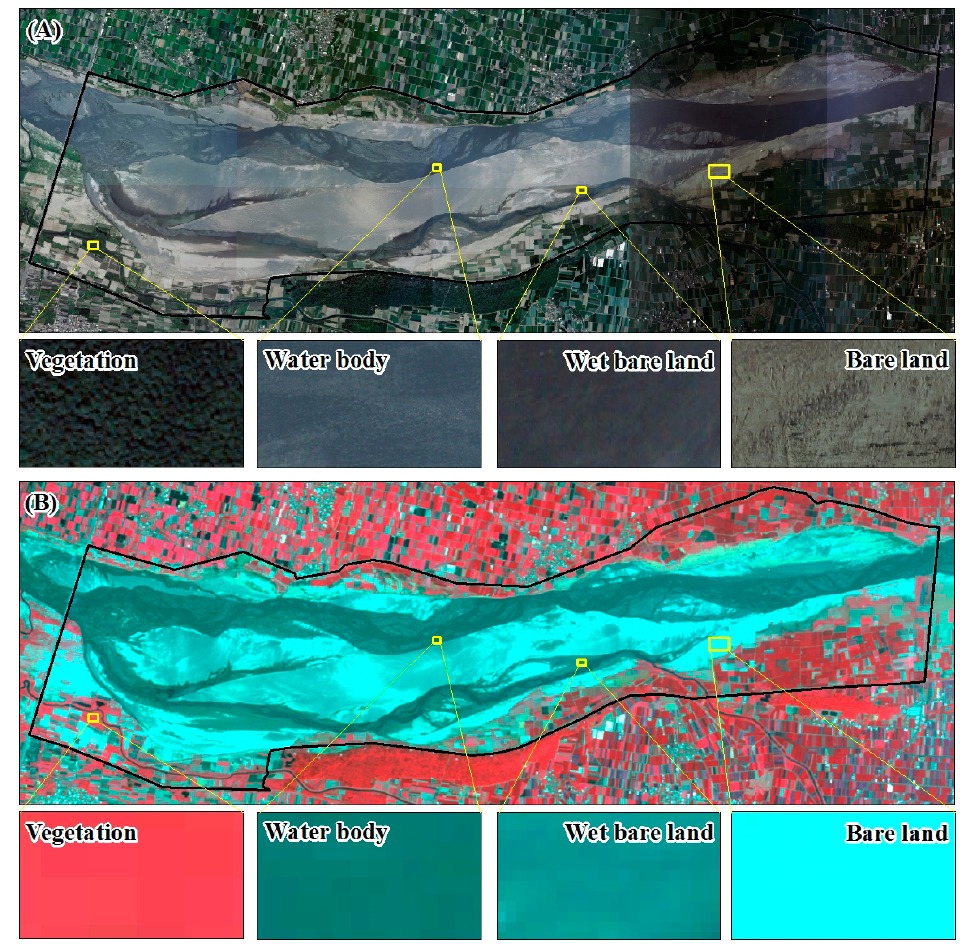
Figure 5. Training samples ( A ) aerial photo ( B ) satellite image (false color composite).